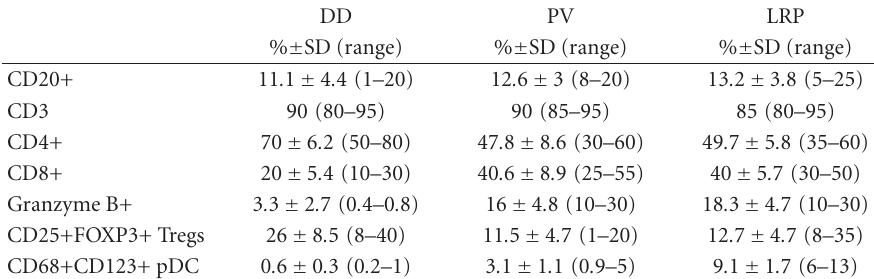
Table 1: Quantitative data